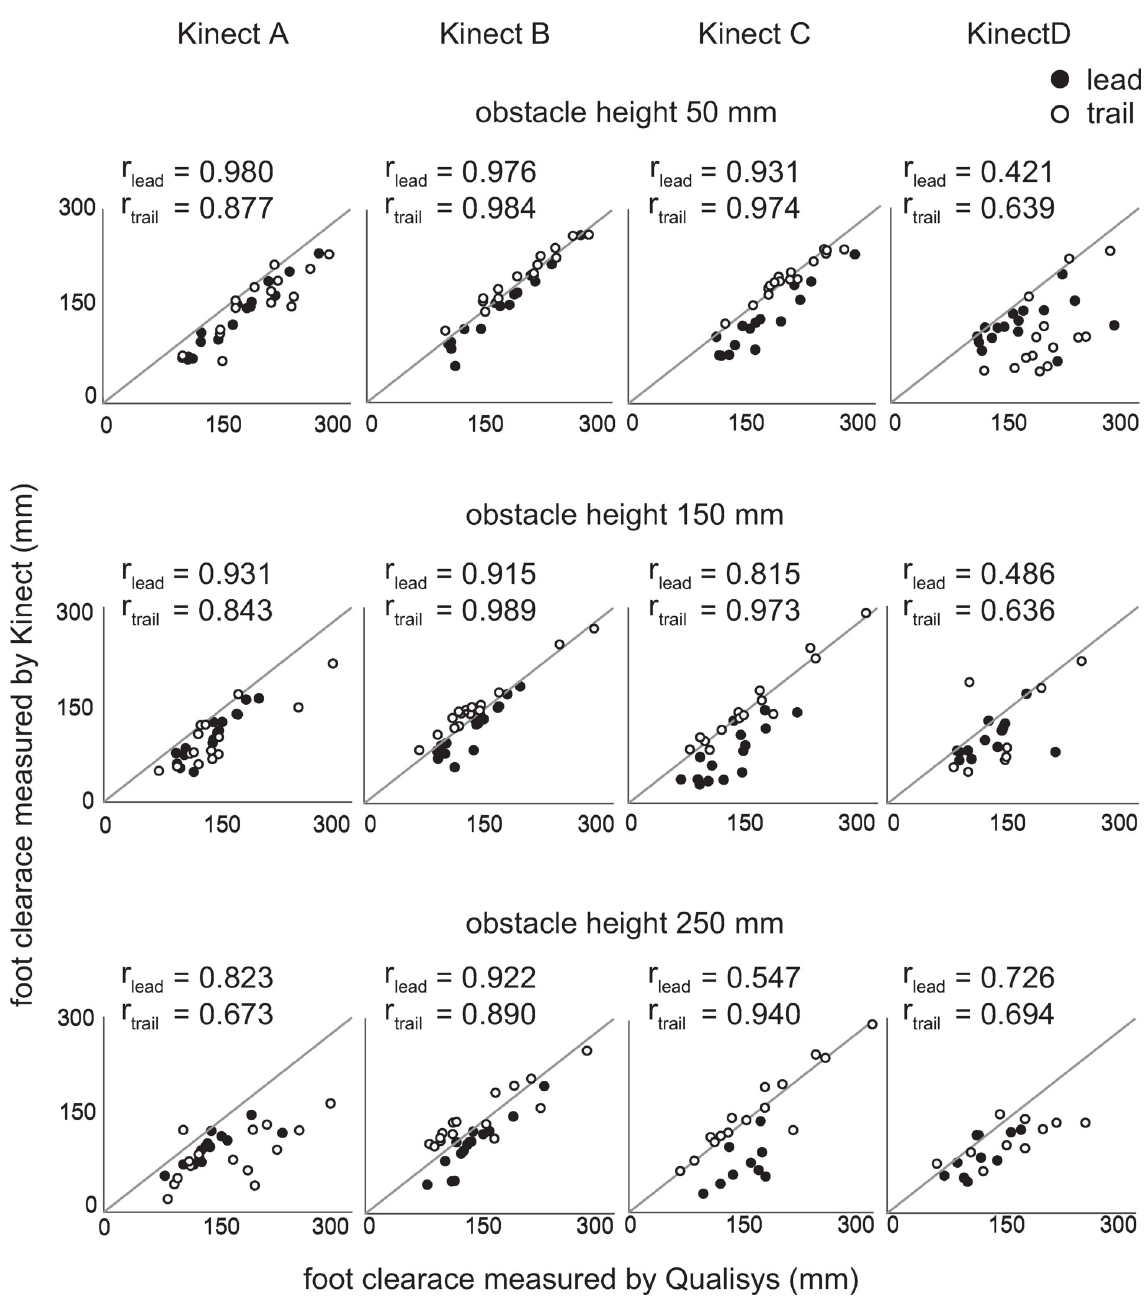
Fig 5. Relationship between the foot clearance measured by the Kinect and Qualisys. The diagonal straight lines represent the identity line, y = x. The black circles represent the data for the lead limb, and the white circles represent those for the trail limb. Pearson’s correlation coefficients were calculated separately for the lead and trail